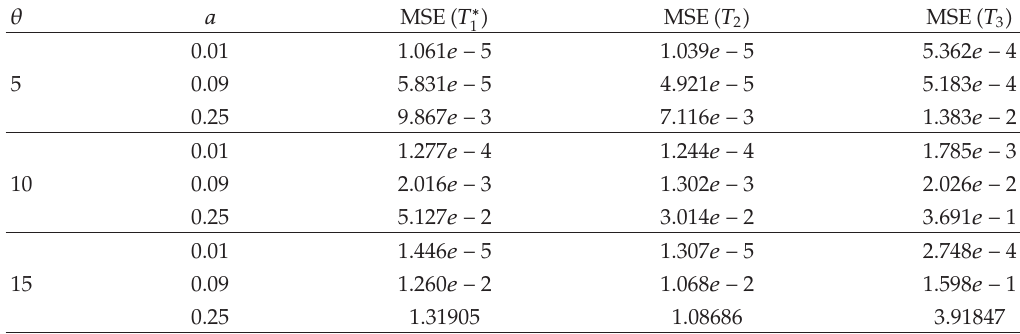
, T 2 , and T 3 when n (cid:5) 10. 1